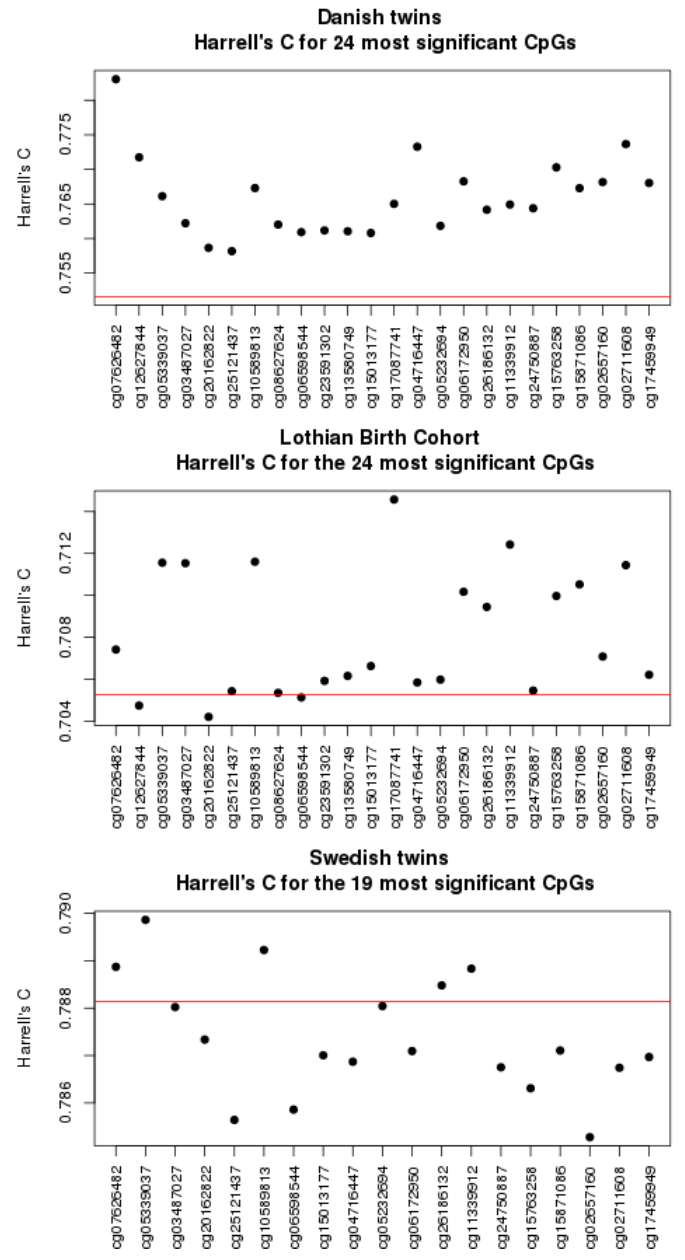
Figure 1. 10-fold cross-validated Harrell’s C for the 24 most significant sites in the univariate analysis. Sex, age, and cohort are included in the model. The red line corresponds to the model based on sex, age, and cohort only.